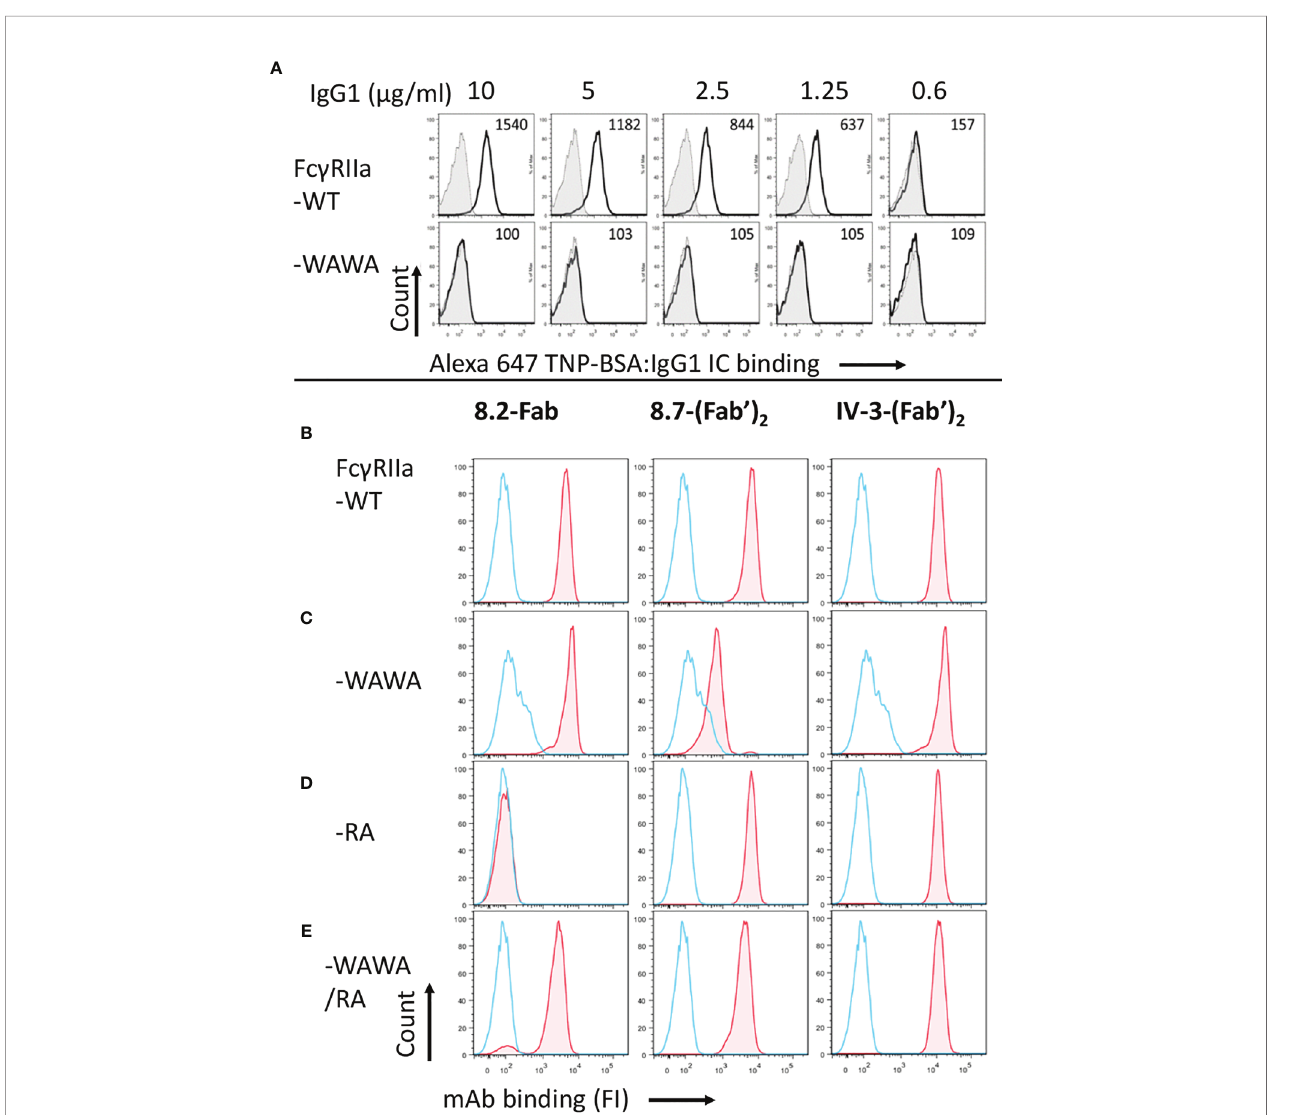
FIGURE 2 | The receptor mutant Fc g RIIa-WAWA does not bind ICs and Fc g RIIa-RA is inactive in mAb 8.2 Fab binding. (A) fl ow cytometry analysis of IgG immune complex binding by IIA1.6 cells expressing Fc g RIIa-WT (upper panel) or mutant Fc g RIIa-WAWA (lower panel) inactivated for Fc binding. Cells were reacted with Alexa-647 labelled TNP-BSA:anti-TNP hIgG1 ICs at the indicated concentrations. The background binding to parental IIA1.6 cells for each concentration is shown as fi lled grey histograms. (B – D) epitope mapping/validation of mAb 8.2, by fl ow cytometry of anti-receptor mAb-biotin staining of IIA1.6 cells expressing (B) Fc g RIIa-WT, (C) mutant Fc g RIIa-WAWA, (D) mutant Fc g RIIa-RA or (E) co-expressing Fc g RIIa-WAWA and Fc g RIIa-RA. Bound mAb was detected using streptavidin conjugated PE, blue histograms show staining with streptavidin conjugated PE alone. See Supplementary Figure 2 for a summary of the expression